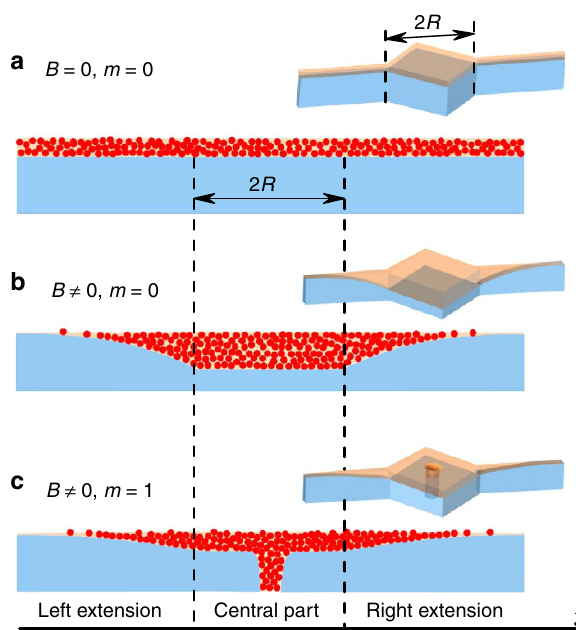
Figure 1 | QP density and gap distributions in a S disc. The S gap E g ( B , x ) in a S disc with narrow extensions (Sample A) is represented by the height of the blue volume, while the QP density n qp ( x ) is shown by red circles; m is the vorticity of the island, B is the magnetic field acting on the sample. The wide central part of a Sample A of size 2 R is limited by vertical dashed lines, the narrow extensions are located on the sides. ( a ) Uniform zero magnetic field state; ( b ) Meissner state with reduced E g ( B , x ) in the central part at small fields in a vortex free state; ( c ) Single-vortex state with smaller gap reduction outside the vortex core than in b . The 3D schematics depict the corresponding E g ( B , x ) (in blue) and n qp ( x ) (in orange